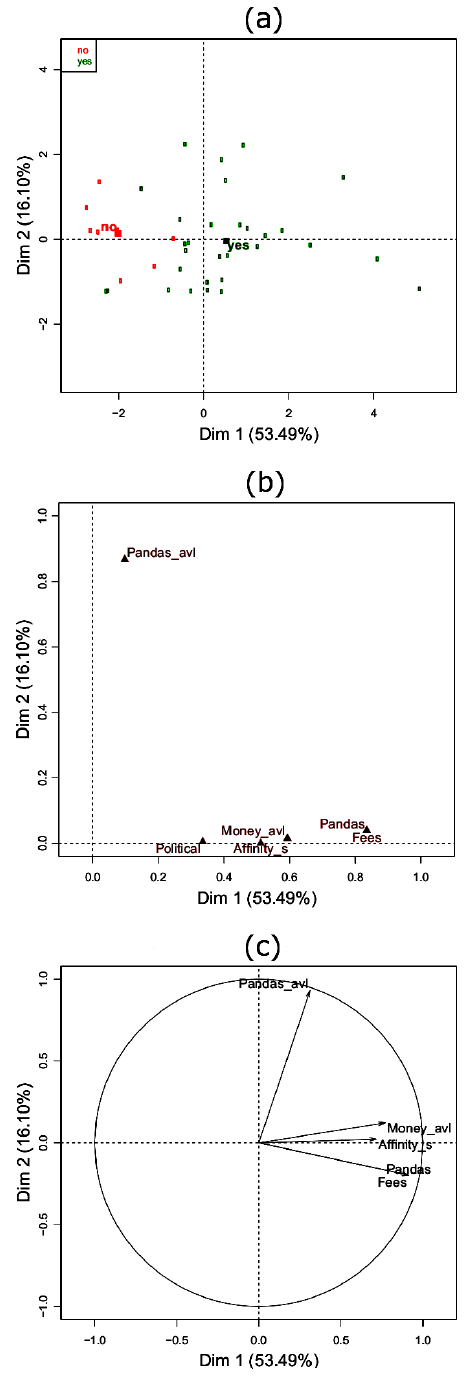
Fig. 7 . Plots produced in the output report by the factor analysis for the mixed data tool (Causes toolset) of the Telecoupling Toolbox. (a) Individual factor map, with units colored based on categories from the political will variable (red = no, green = yes); (b) graph of the variables; (c) graph of the quantitative variables on the unit